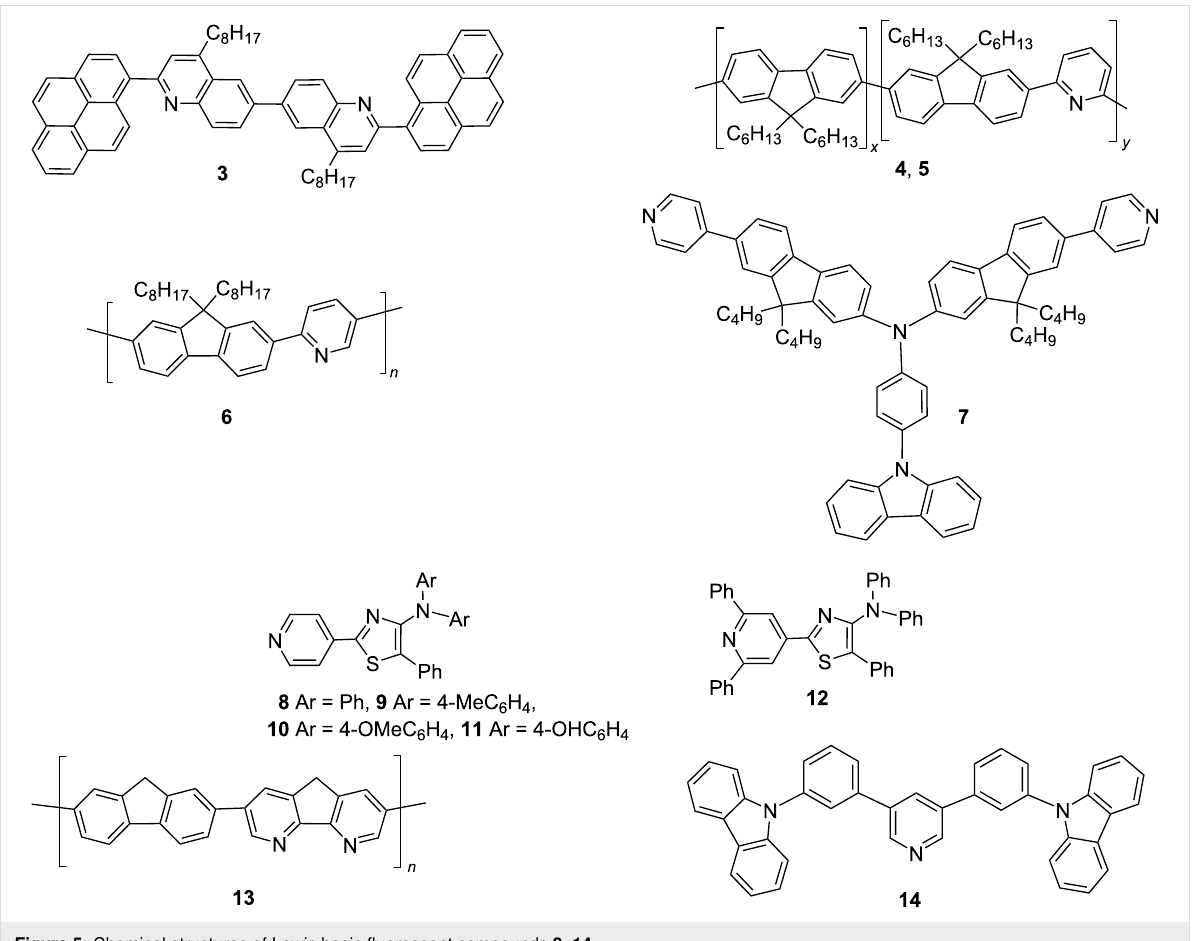
Figure 5: Chemical structures of Lewis basic fluorescent compounds 3–14 .